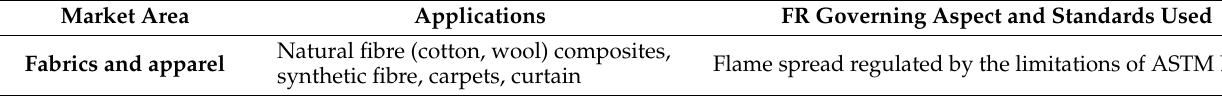
Table 1. Application of flame